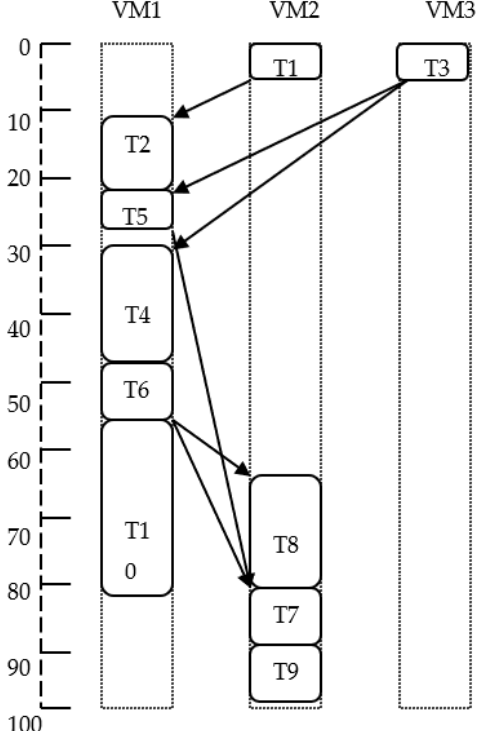
Figure 6. Scheduling of DAG with modified HEFT algorithm (use of minimum computation cost in rank calculation). The schedule length is 98.